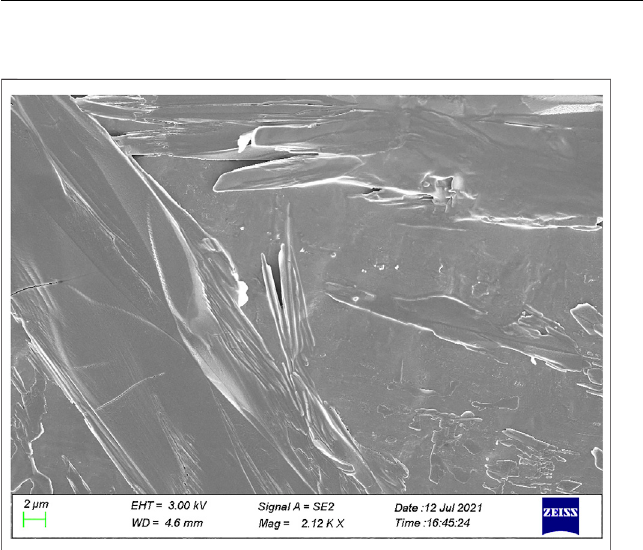
FIGURE 4 | EDS images of the schistose crystal (A) and the particle (B) in mixed crystal of DHB and 30 cP hydroxyl silicone oil.